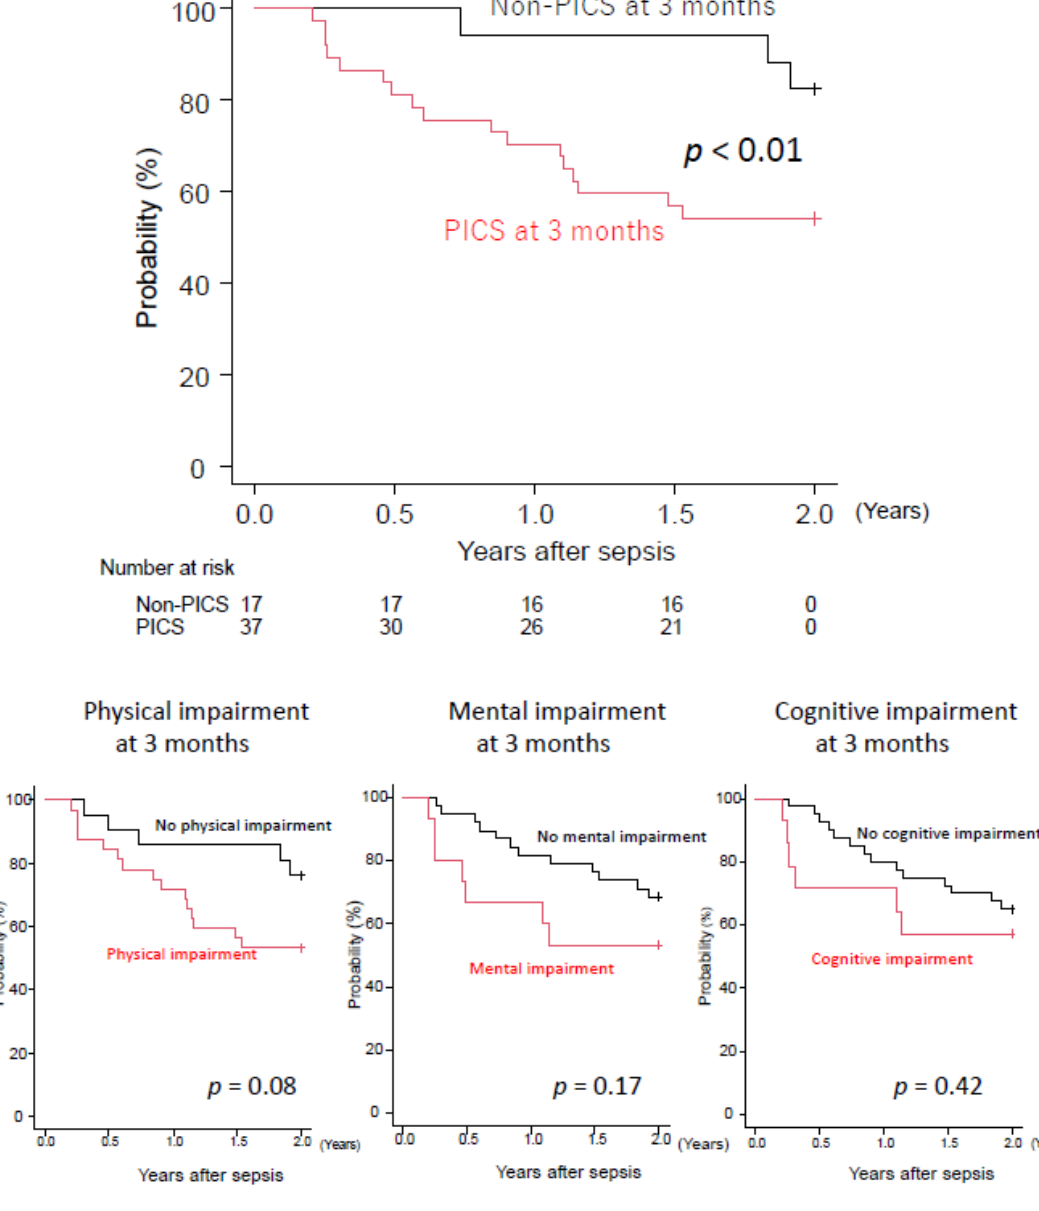
Figure 5. Kaplan–Meier analysis for 2 years of PICS, physical impairment, mental impairment, Figure 5. Kaplan – Meier analysis for 2 years of PICS, physical impairment, mental impairment, and and cognitive impairment at 3 months after sepsis. PICS: post-intensive care cognitive impairment at 3 months after sepsis. PICS: post-intensive care syndrome.